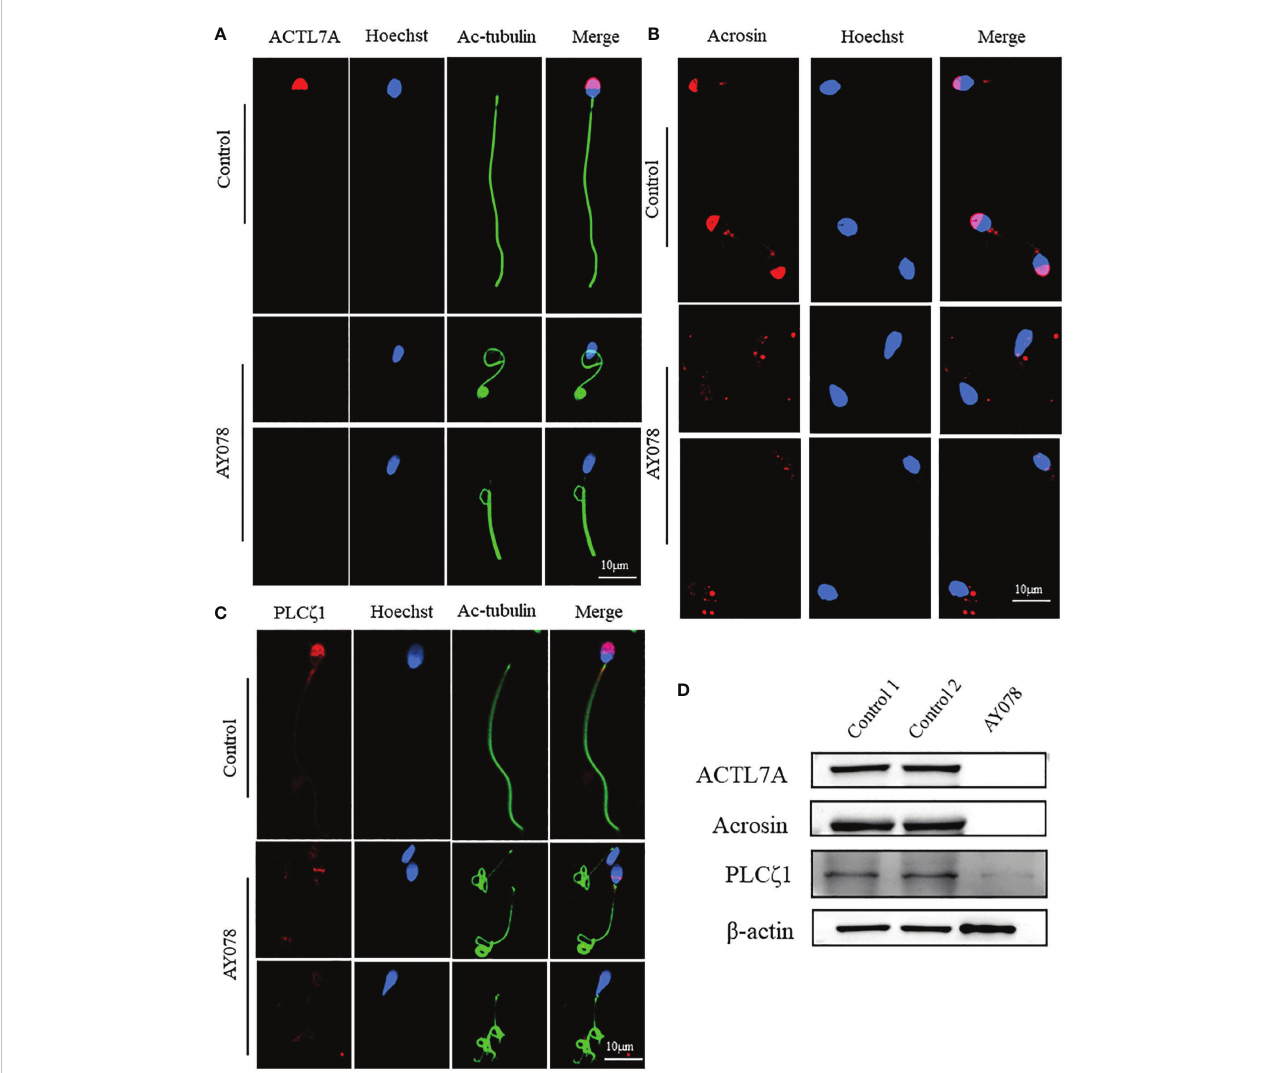
FIGURE 5 The distribution and expression of acrosomal associated proteins in AY078 and control individual. (A – C) Immuno fl uorescence staining assays were performed on the sperm of AY078 and normal subject using anti-ACTL7A(red in A), anti-ACROSIN (red in B) and anti-PLCz1 (red in C). Compared with cap-like staining of ACTL7A and ACROSIN, localized on anterior head in normal sperm, the signal in P1 of those proteins were absent from acrosome. The PLCz1 normally localized in cap-like area of acrosome, while was absent, decreased and dispersive from normal region. Anti-ac-tubulin (green) marked the sperm fl agella, Hoechst (blue) marked the nucleus of spermatozoa. Scale bars: 10mm. (D) WB assays analysis the expression levels of ALTL7A, ACROSIN and PLCz1 in sperm obtained from P1 and normal control. The results of WB assays were accordance with those of immuno fl uorescence assays described above. b-actin was used as internal